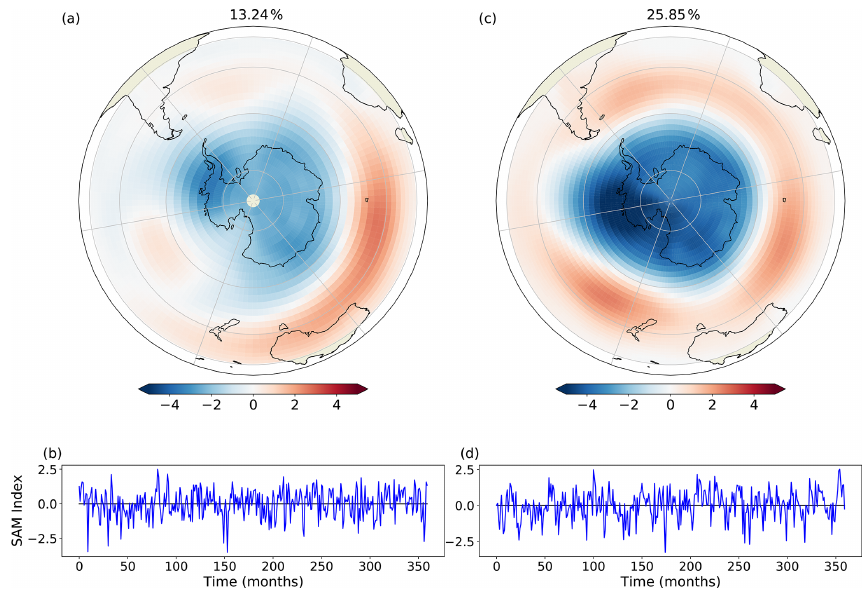
Figure 16. The SAM as represented by the first EOF and PC computed using deseasoned and latitude-weighted sea level pressure for FORTE 2.0 (a, b) and 20CR (c, d)